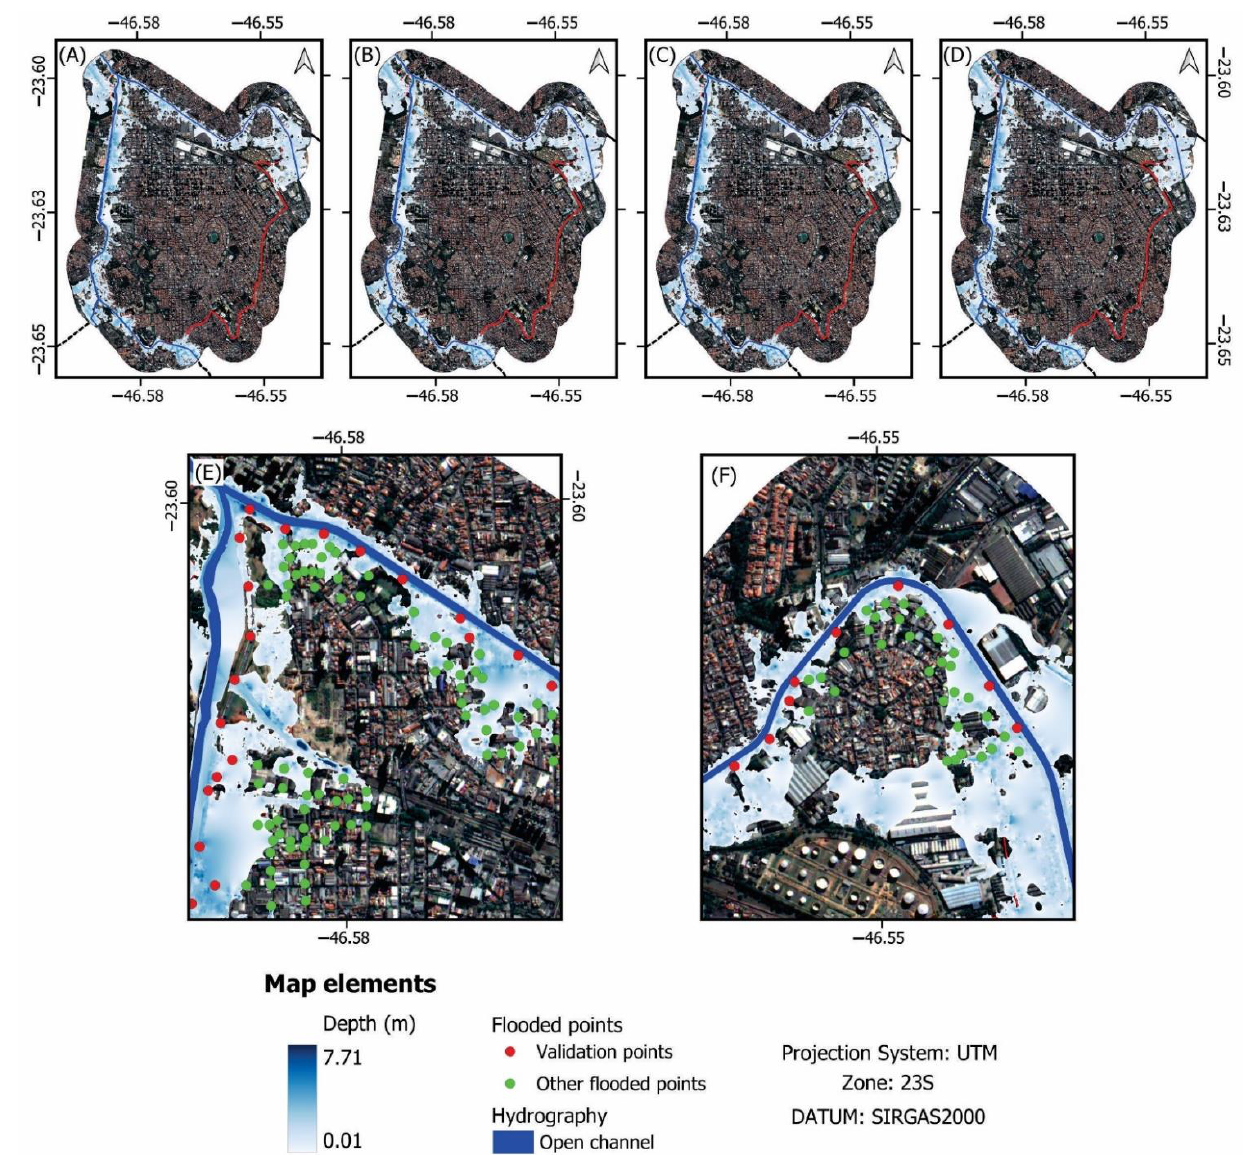
Figure 7. Flood maps generated in HEC-RAS. ( A – D ) represent the simulations with the computing interval of 1, 15, 30, and 60 s, respectively, with the finer DTM (0.50 m) with refined channel mesh. ( E ) is a zoom-in of the confluence of Tamanduateí River and Meninos Brook in the northwestern region of the study area. ( F ) shows a zoom-in of Tamanduateí River in the northeastern part of the analyzed reach. Red points are used for validation, while the green points represent other flooded points reported by the citizens of São Caetano do Sul. The thick lines in dark blue correspond to the open channels. The different shades of blue in polygonal shape account for the different depths of the flood zones.